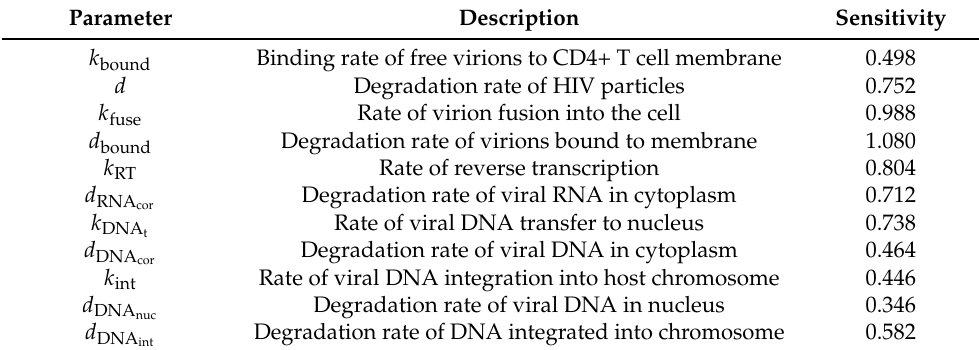
d DNA nuc d DNA Degradation rate of DNA integrated into int